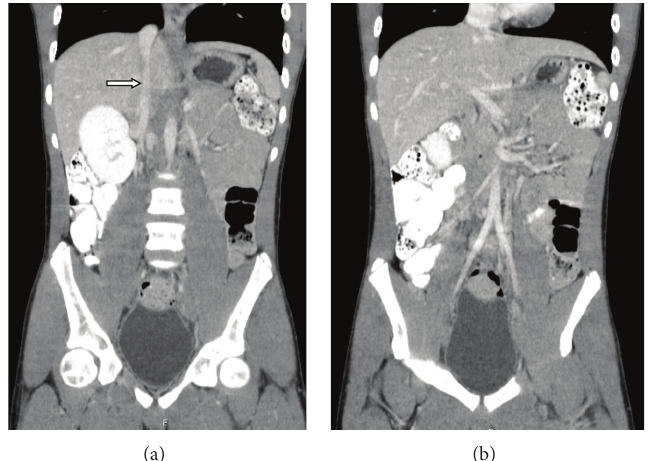
Figure 2: Contrast enhanced abdominopelvic CT scan. Two contiguous coronal reformations showing patent suprarenal inferior vena cava (white arrow). Note absence of the infrarenal inferior vena cava in the right image.